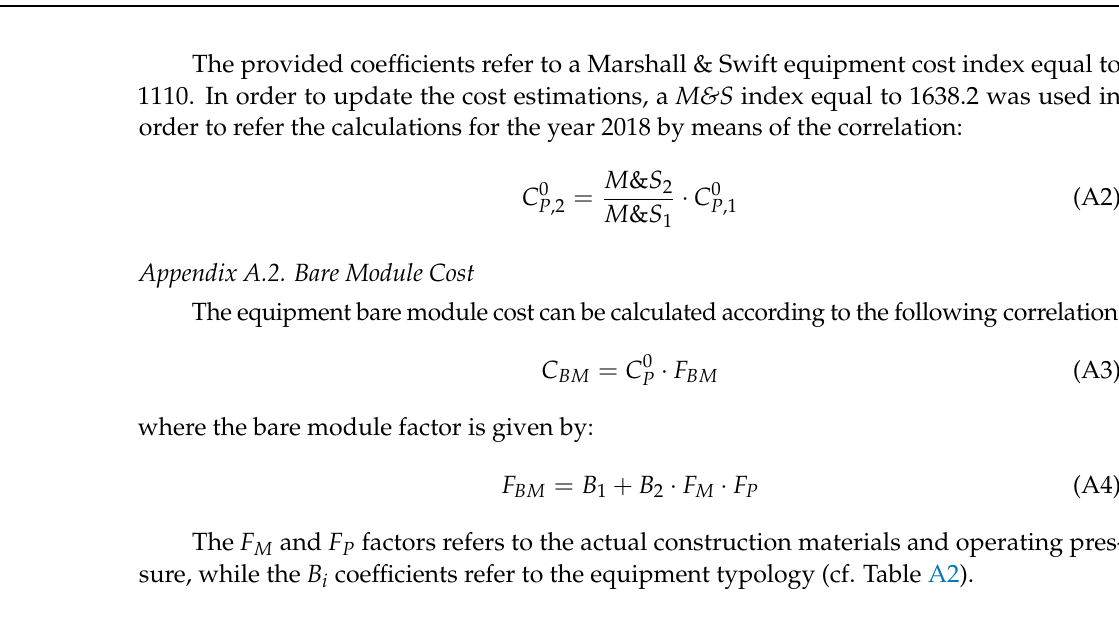
Table A2. Equipment cost in base condition